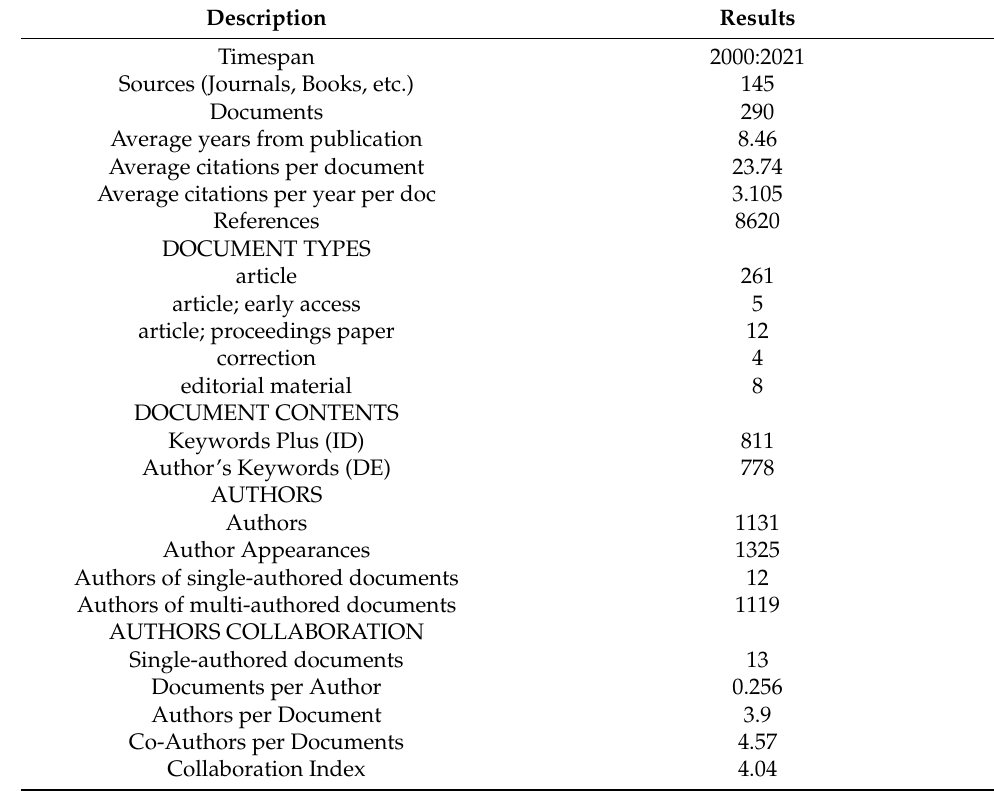
Table 1. Major information on biodegradation of plastics-related research from 2000 to